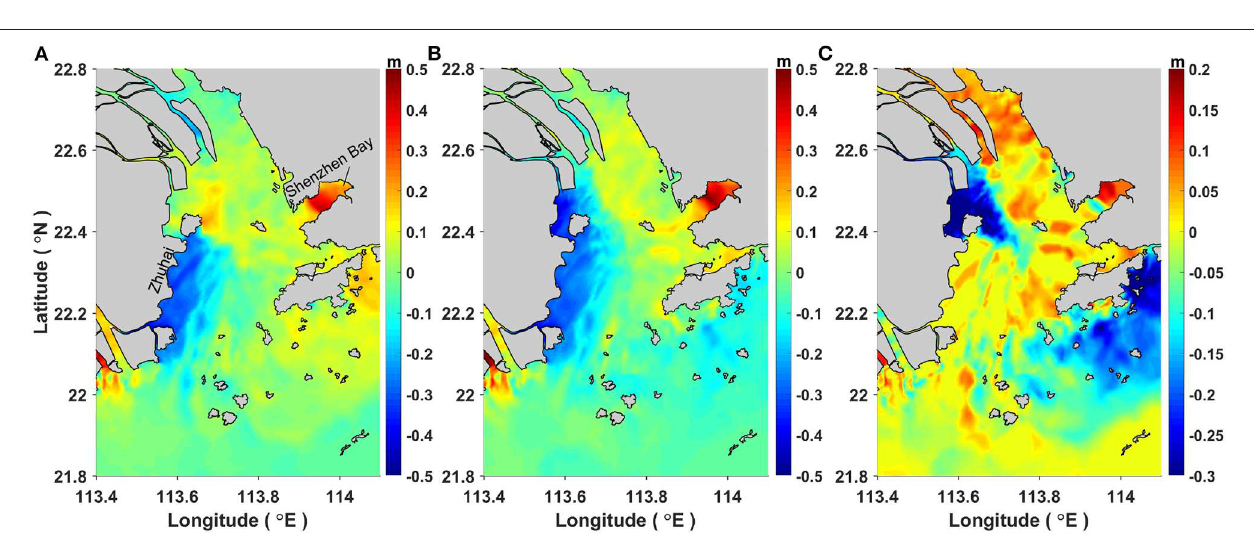
FIGURE 7 | Spatial distributions of (A) the differences between the maxima of ζ PS and ζ SO (i.e., ζ max PS − ζ max SO ), (B) the differences between the maxima of ζ ST and ζ SO + ζ TO (i.e., ζ max ST − [ ζ SO + ζ TO ] max = [ ζ PS + ζ TO ] max − [ ζ SO + ζ TO ] max ), and (C) the differences between (A,B) , during the passage of Typhoon